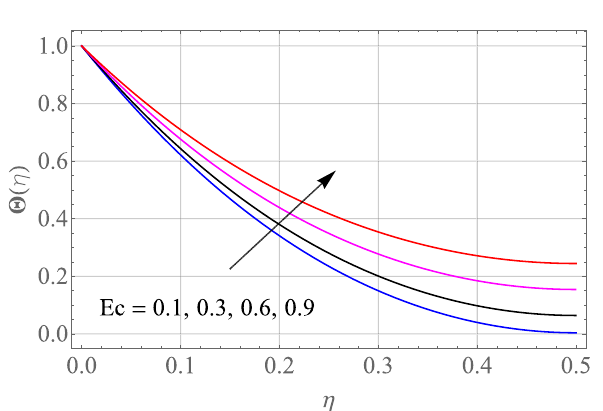
Figure 8. Alterations in �(η) as Ec raises. When M = S = 0.1, Pr = 6.2, Gc = Gr = 0.2, Nb = Nt = 0.3, Sc = 0.3